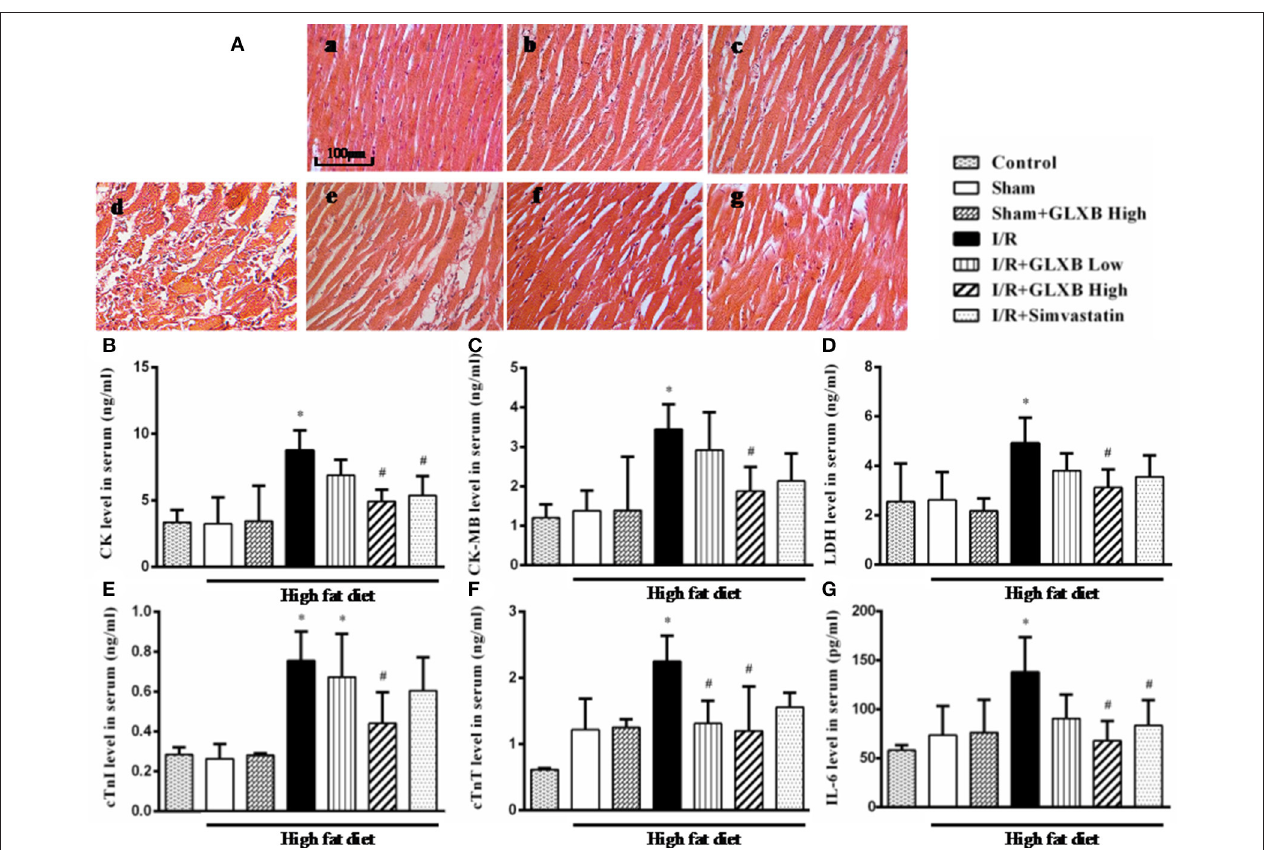
FIGURE 4 | The effect of GLXB on I/R-evoked myocardial injury in rats. (A) Representative photographs of HE-stained myocardium (20 × ) in Control (a) , Sham (b) , Sham + GLXB High (c) , I/R (d) , I/R + GLXB Low (e) , I/R + GLXB High (f) , I/R + Simvastatin (g) . Bar = 100 µ m. (B) Serum levels of CK in different groups. (C) Serum levels of CK-MB in different groups. (D) Serum levels of LDH in different groups. (E) Serum levels of cTnI in different groups. (F) Serum levels of cTnT in different groups. (G) Serum levels of IL-6 in different groups. Data are mean ± SEM, n = 6. * P < 0.05 vs. Sham group, # P < 0.05 vs. I/R